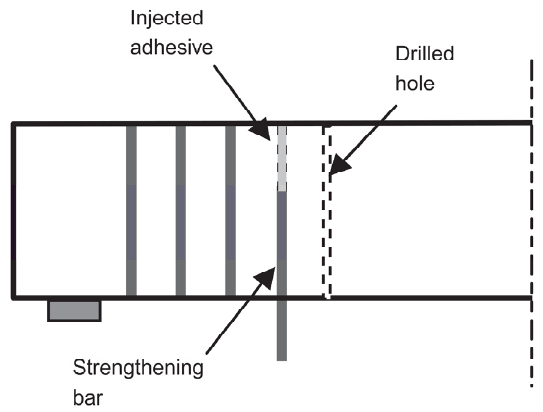
Figure 15. Shear strengthening using deep embedment techniques [57].